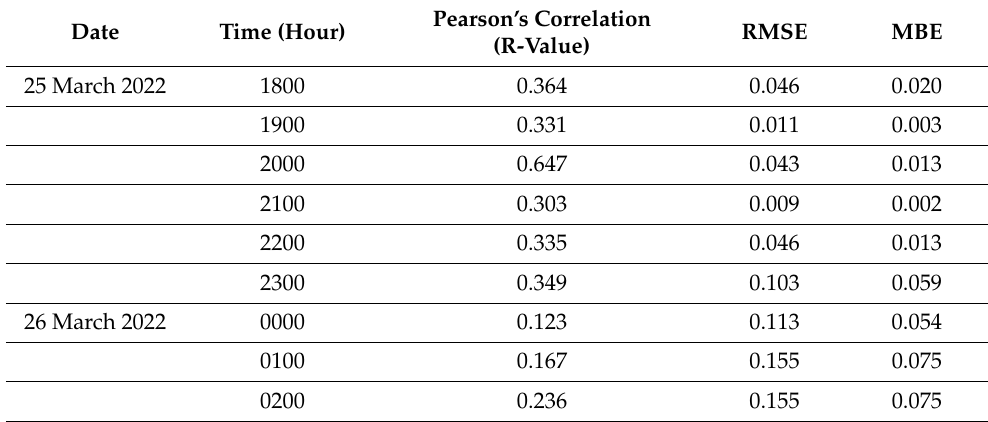
Table 4. Comparison between field measurements and computer-simulated